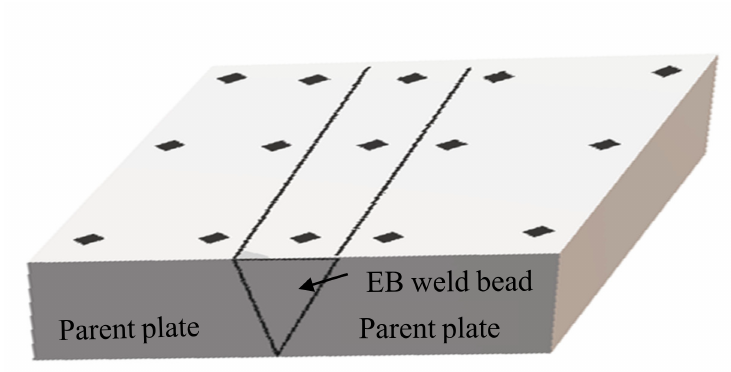
Figure 1. Illustration of the welded plates and the areas of hardness tests.